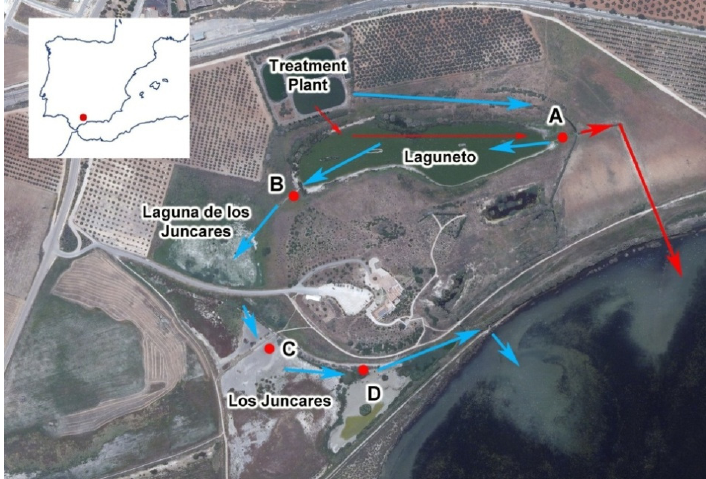
Figure 1. Location map of the study area, sampling points, and water flow through the semi-natural ponds system ( blue arrows ) direct to the Ramsar wetland. Before restoration in 1996, water flows followed the red arrows, but this is no longer possible.